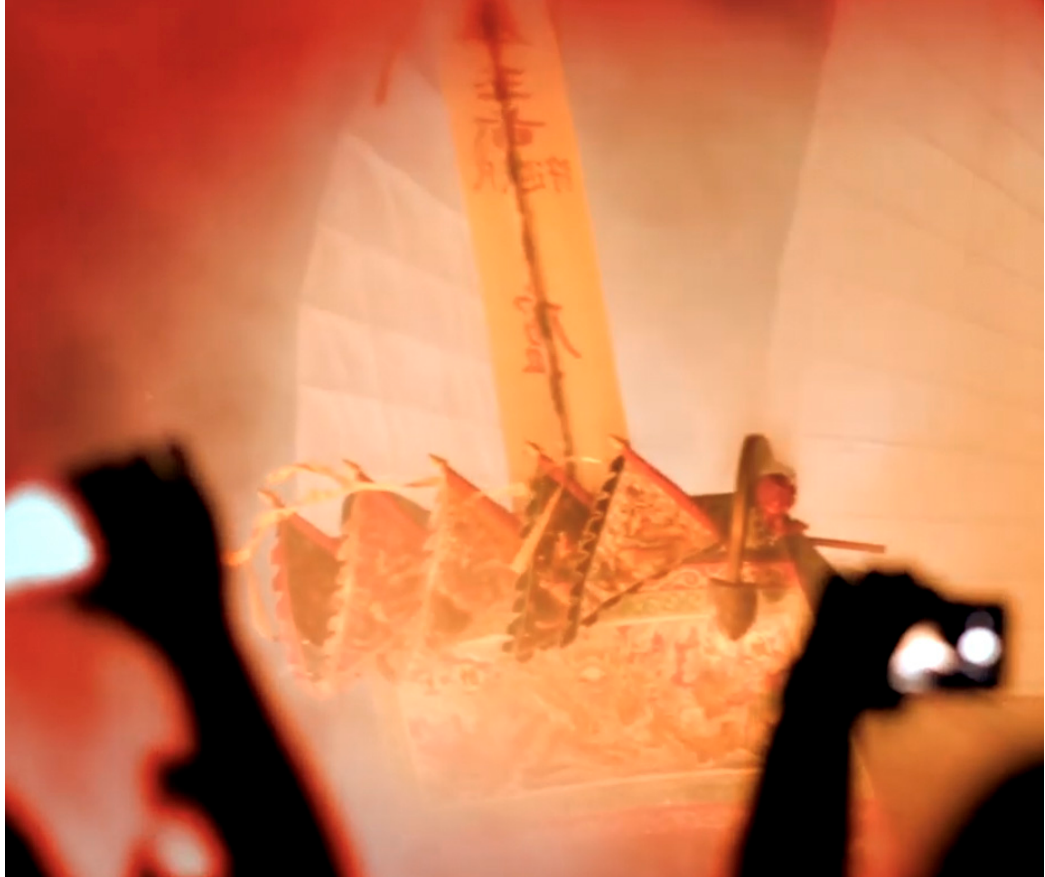
Figure 8. The Wang Yeh boat burning festival in Donggang, Taiwan. Image courtesy of Ye Mimi.